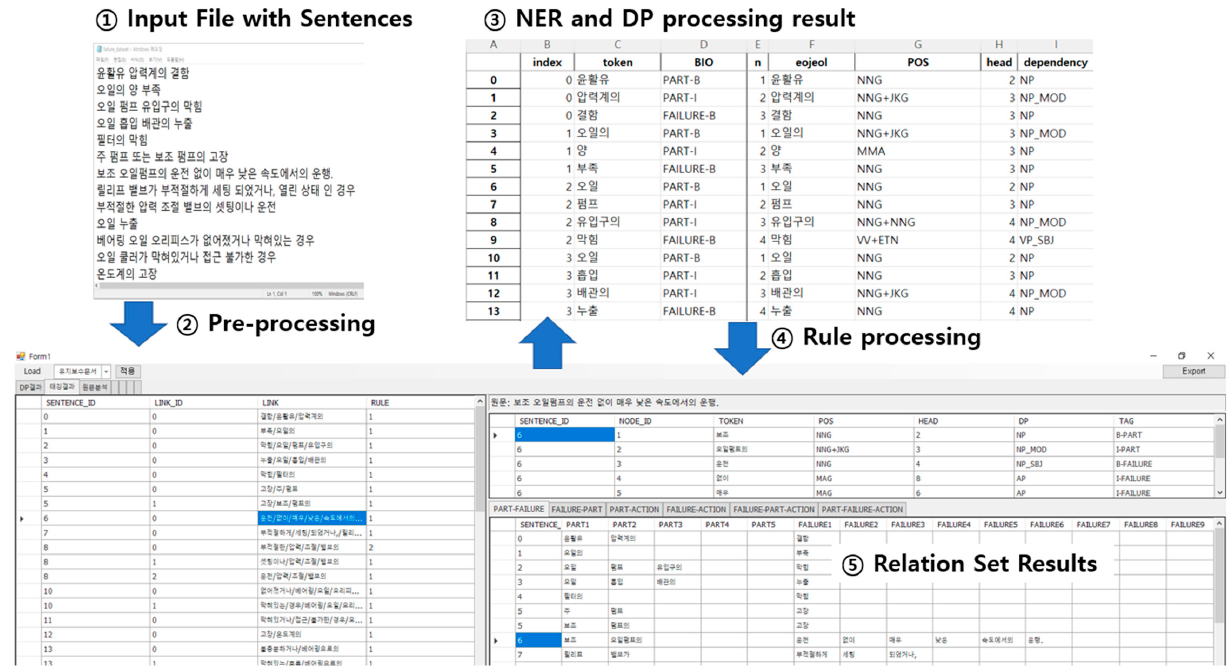
Figure 4. Screenshots of the proposed rule-based system.